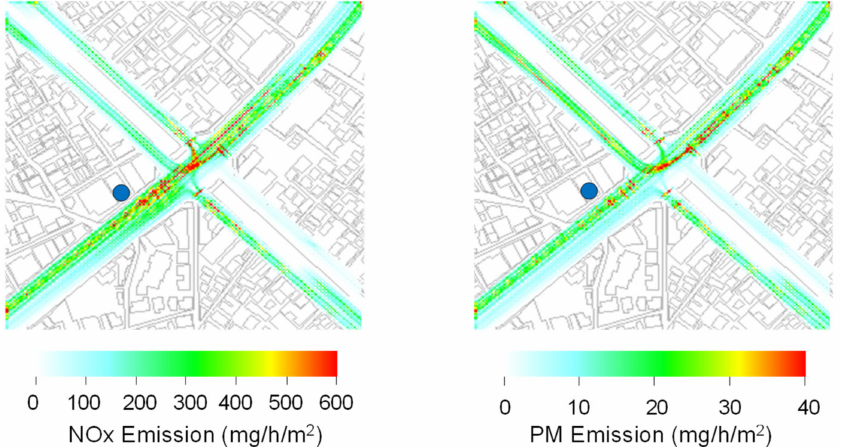
Figure 18. Estimated automobile emission distribution around the Kamiuma intersection (the blue circle indicates the Kamiuma Roadside Air Quality Monitoring Station (RAQMS)).